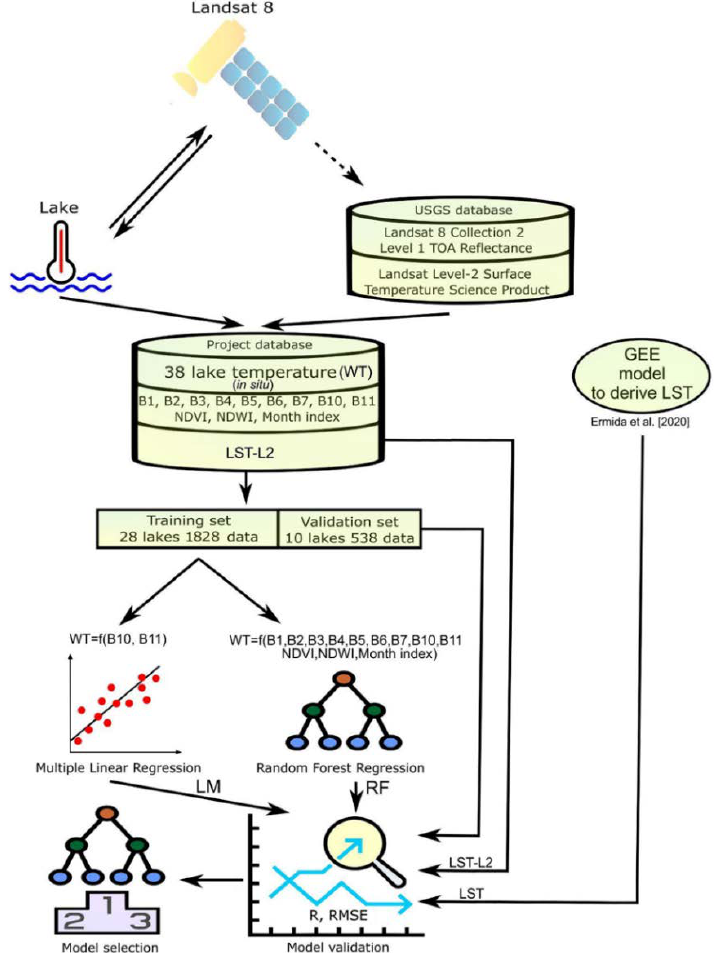
Figure 1. Flowchart of lake water temperature prediction. One method was developed by Ermida et al. (2020) [39].